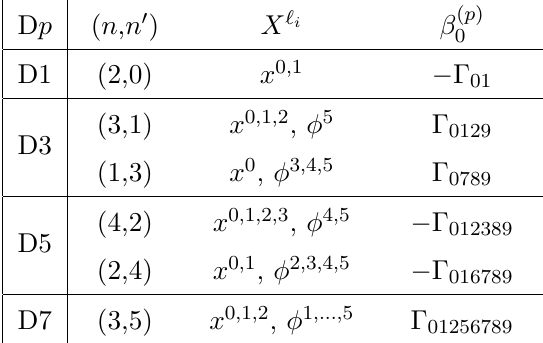
Table 2 . Con(cid:12)gurations of Non-AdS